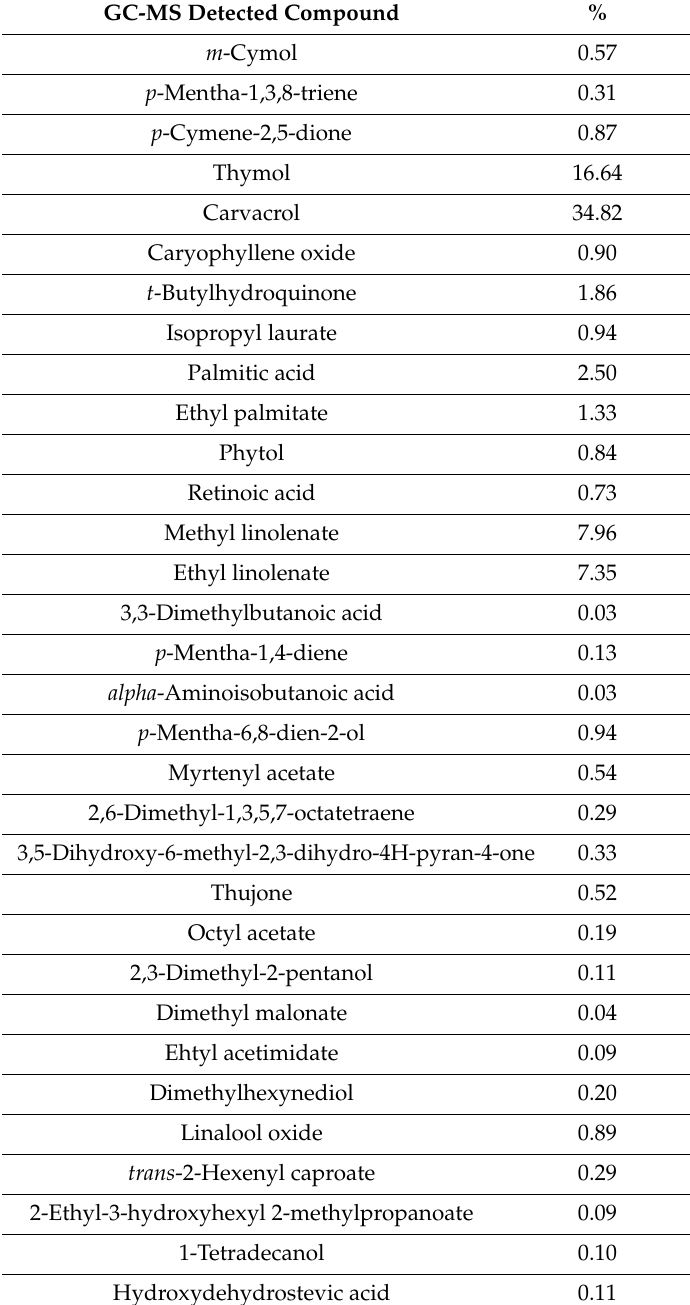
Table 2. GC-MS profile of oregano extract. Plant metabolites and their relative abundance, detected in HCOE by GC-MS analysis, are reported. The relative abundance of each molecule was indicated as a percentage value with respect to the total mixture (100%). Values represented the mean of three independent experiments. The SD for each measurement was always < 5% of the respective molecule peak